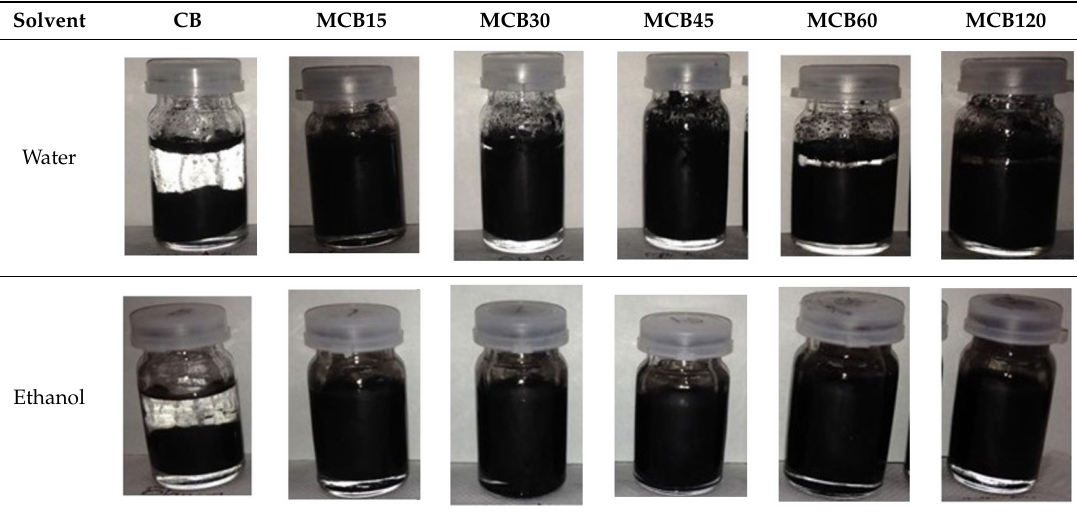
Figure 4. TEM images and EDS spectra of the carbon black and the MCB60 samples. Table 4. Stability of the dispersion of the carbon black and modified carbon black with citric acid in water and